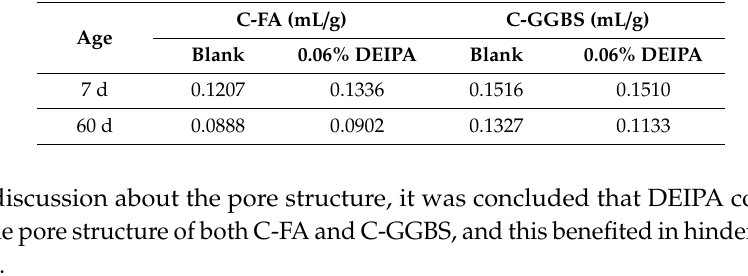
Table 6. Porosity of C-FA and C-GGBS systems.